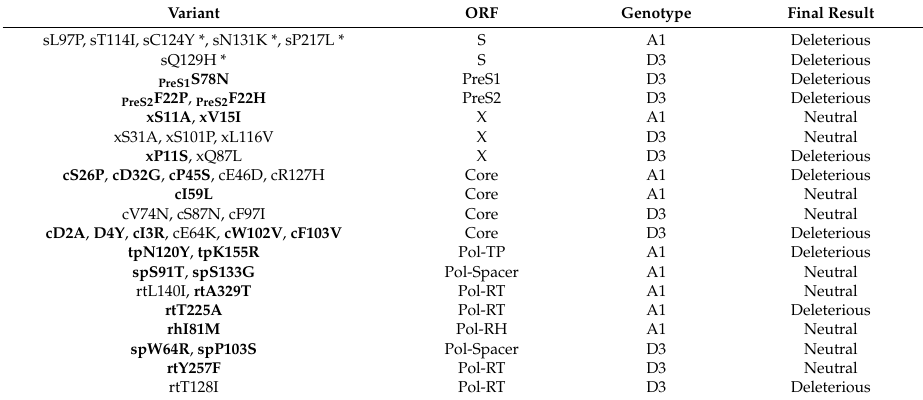
Table 3. Results of predicted effects of study occult hepatitis B infection (OBI)-associated mutations on different regions of